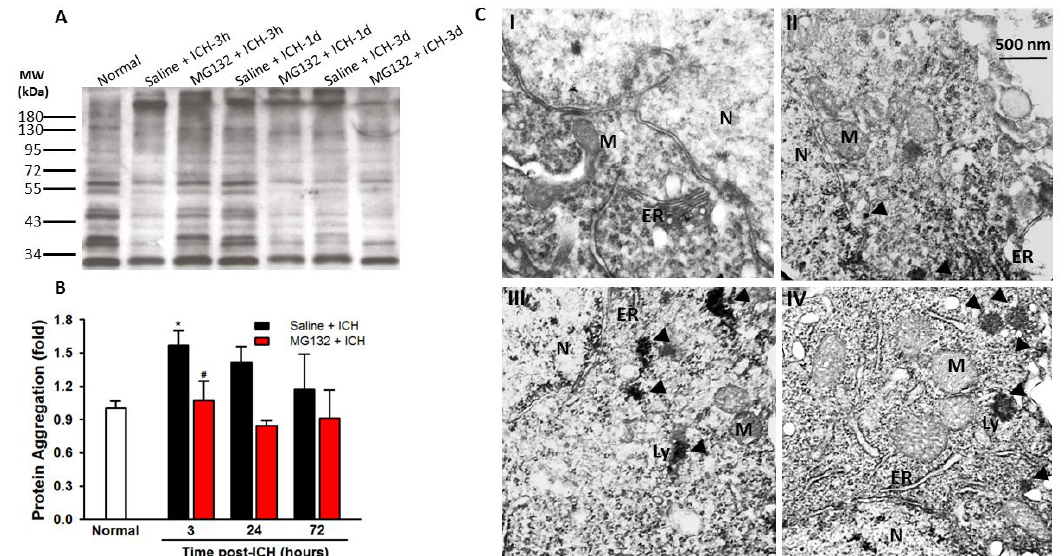
Figure 4. Ubiquitinated protein aggregates in ICH striatal. Representative naïve SDS-PAGE of ubiquitinylated protein accumulation ( A ) and statistical analysis of high molecular weight ( > 50 kDa) polyubiqutinated protein aggregation in normal, 3, 24, 72 h post-ICH injury, n = 6 each group ( B ). Transmission electron microscopic pictures of neuronal stroma stained with uranyl acetate and lead citrate in region of contralateral striatum (I), perihematomal striatal (II and III) and core (IV) at 3 h post-ICH. ER, endoplasmic reticulum; Ly, lysosome; M, mitochondria; N, nucleus; abnormal protein aggregated (arrow point) ( C ). Values are indicated by means ± SEM; * p < 0.05; compared to the normal group; # p < 0.05; compared to the Saline + ICH group, respectively ( B ).